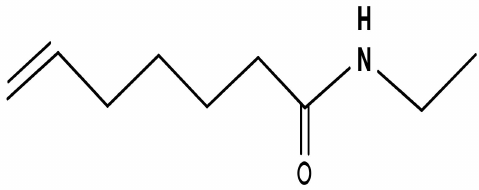
Figure 1. Capsaicin chemical structure.